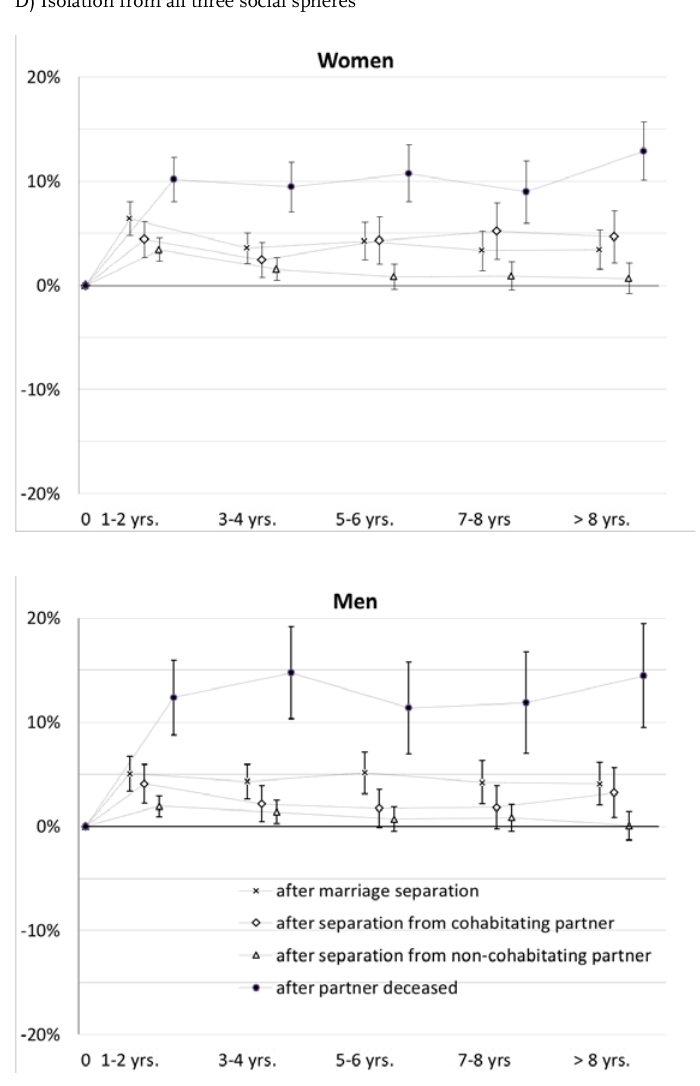
Figure 3 : Time-effects of relationship endings on social isolation (linear-probability models with fixed effects, percentage points and 95%-confidence limits)